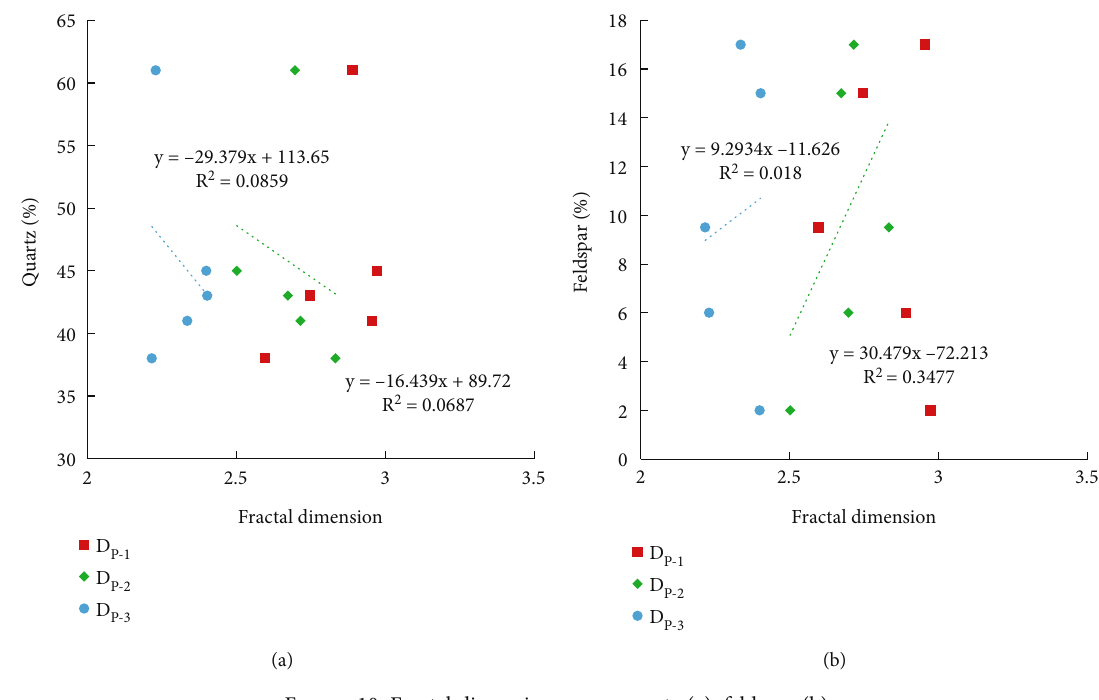
Figure 10: Fractal dimension versus quartz (a), feldspar